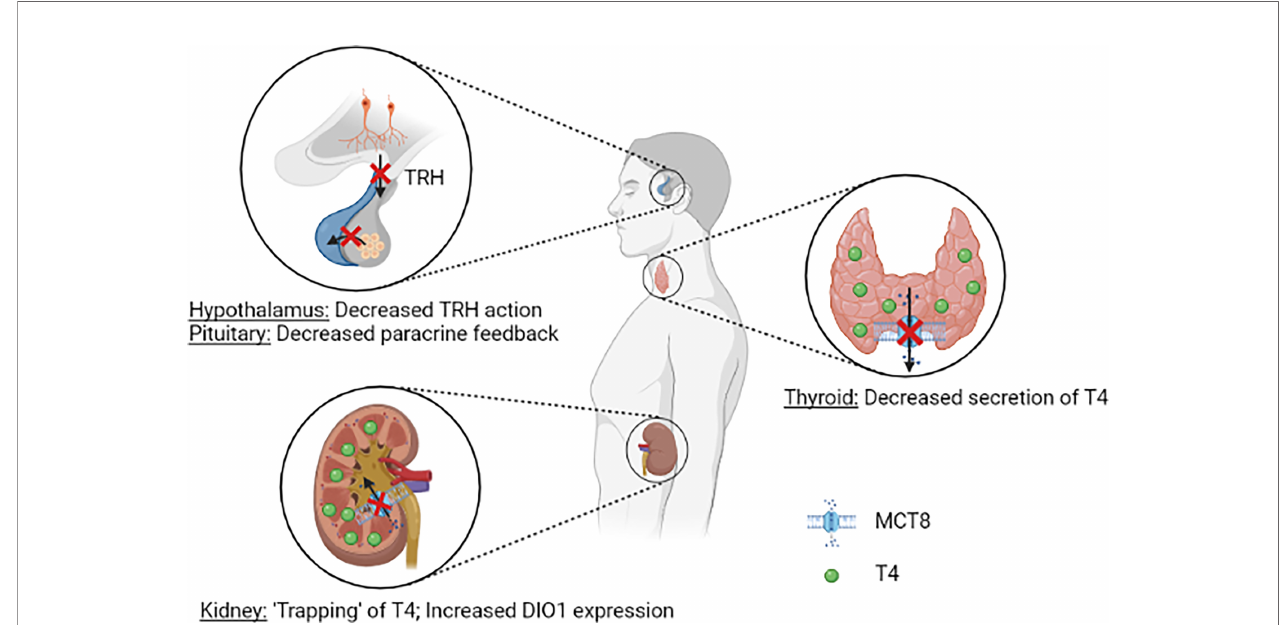
FIGURE 2 | Schematic representation of the current understanding of potential pathogenic mechanisms underlying the abnormal serum thyroid hormone concentrations in patients MCT8 de fi ciency. Loss of MCT8 function may lead to altered thyroid hormone sensitivity in the hypothalamus and pituitary (upper left panel). Loss of MCT8 function results in decreased thyroidal T4 secretion (right panel). Loss of MCT8 function may results in decreased excretion and ‘ trapping ’ of T4 in the kidneys, and subsequent increase in DIO1 expression. TRH, thyrotropin releasing hormone; T4, thyroxine; MCT8, monocarboxylate transporter 8; DIO1, deiodinase type